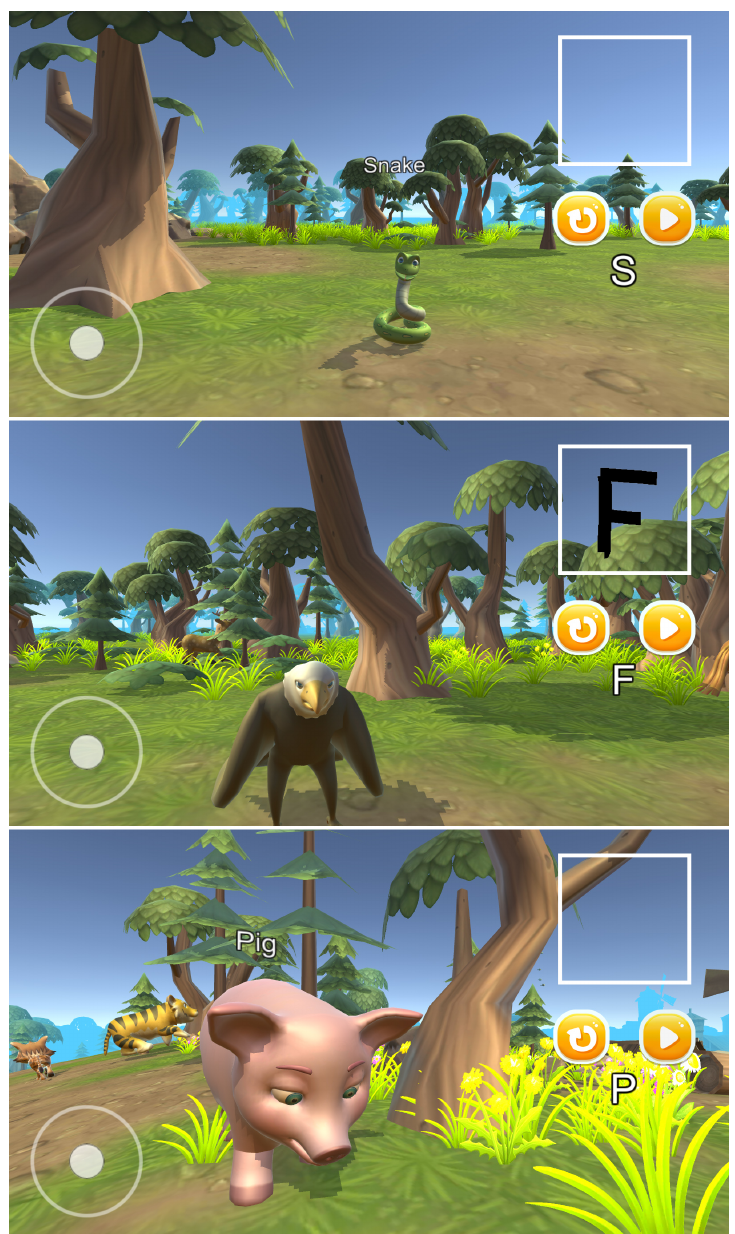
Figure 7. Production results of the mobile platform application